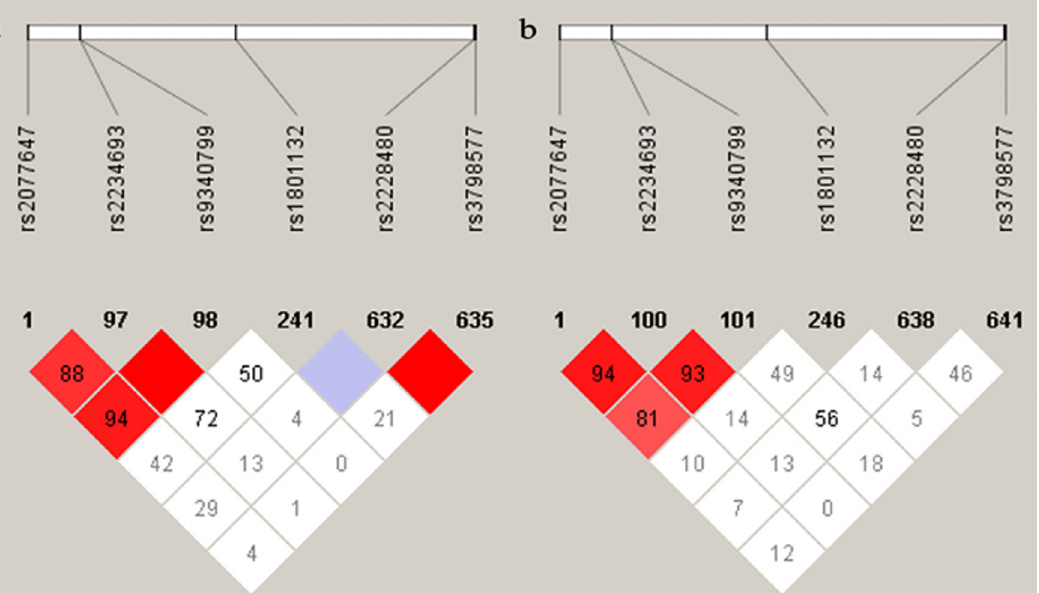
Fig 7. The pattern of linkage disequilibrium in alleles of the ESR1 gene in the different populations, with their |D ’ |. a CEU: CEPH (Utah residents with ancestry from northern and western Europe). b CHB+JPT: Han Chinese in Beijing, China and Japanese in Tokyo,